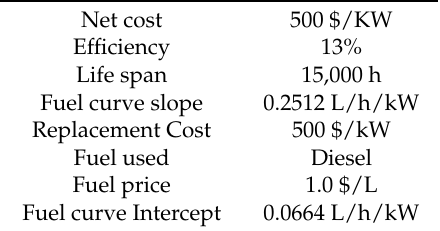
Table A1. Specification of DG used for